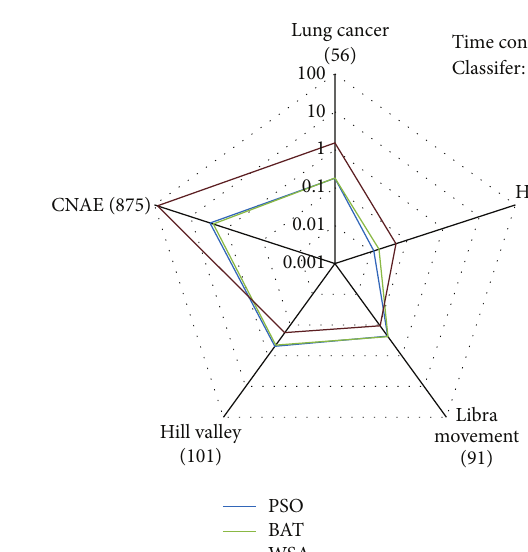
Figure 8: Results in consumption time for Decision Tree are shown visually in radar